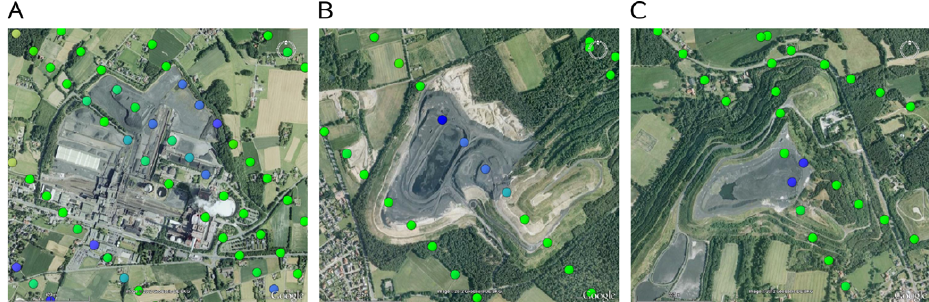
Fig. 4. MAMAP data superimposed on Google Earth aerial imagery of anomaly locations. As can be seen, low X CH 4 (CO 2 ) (blue circles) correlates with areas of excavated material (grey). Panels (A) , (B) and (C) denote the anomalies marked in Fig. 3. Data points denote the centre position of measured areas and are not to scale with observed ground scenes, which are about twice as large and of rectangular shape.